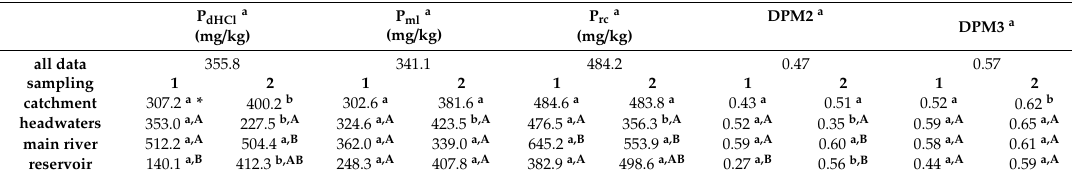
Table 3. Di ff erential P fractions and degrees of P mobilization of sediments (means).